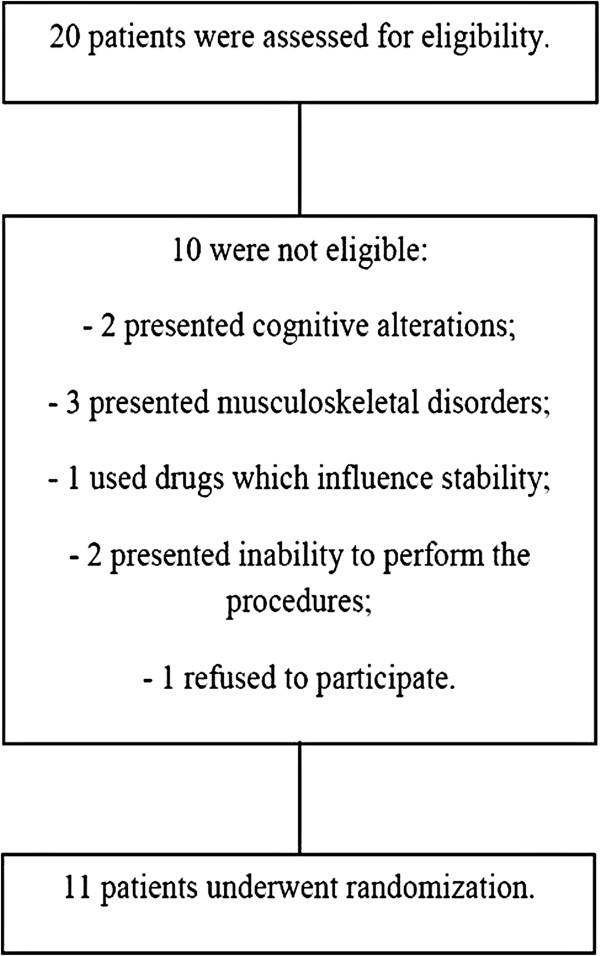
Multicentre trial flow diagram of blind children, including detailed information on the excluded participants.